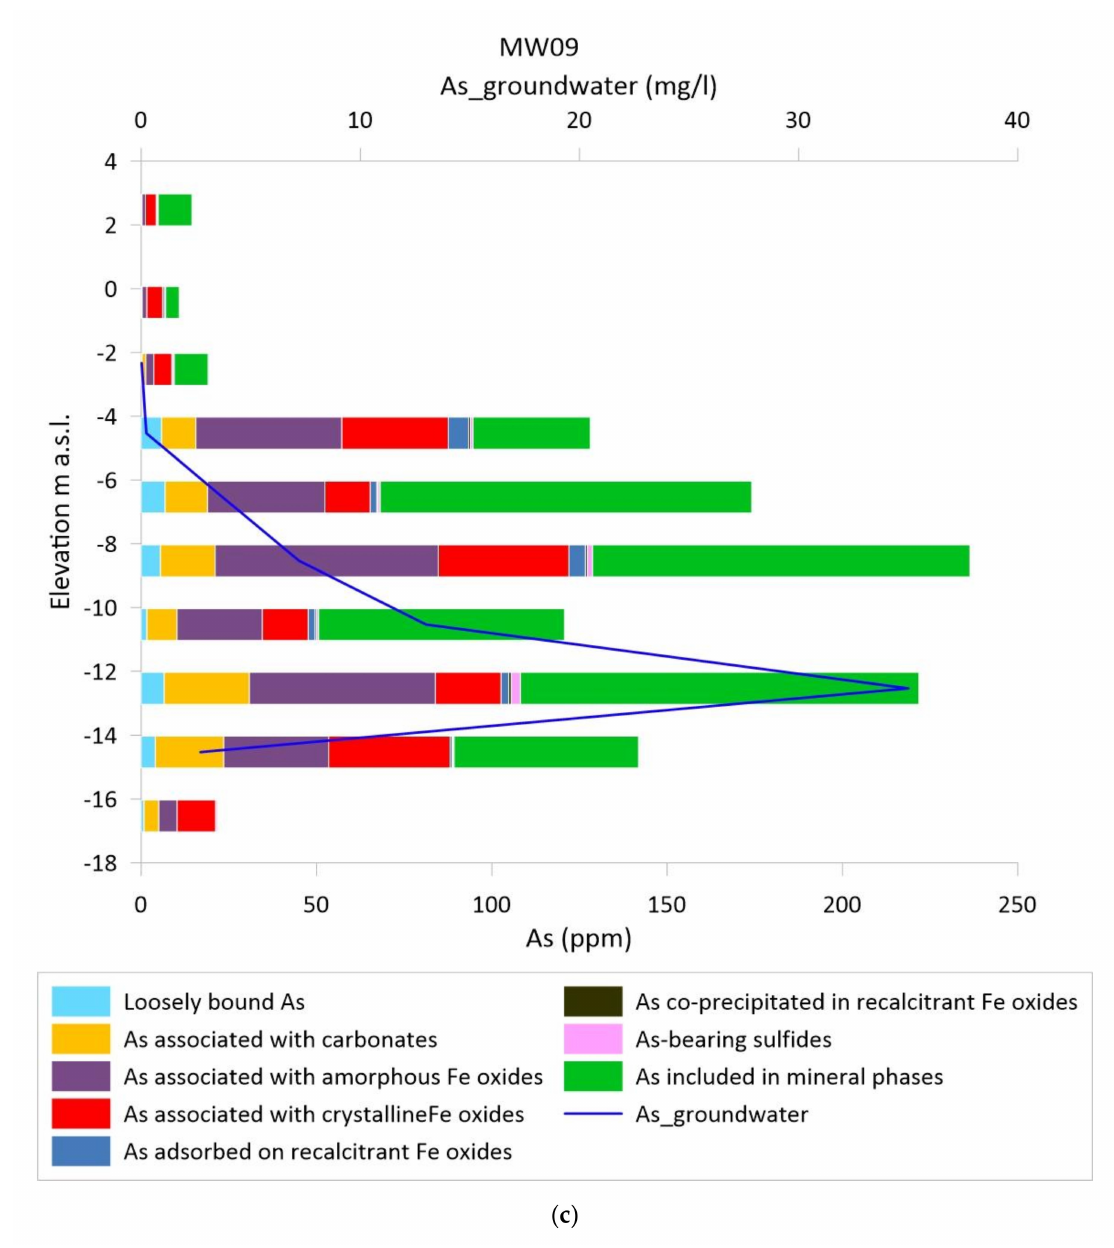
Figure 5. ( a ). Bar chart of sequential extraction results in MW07 compared with dissolved As vertical profile. ( b ) Bar chart of sequential extraction results in MW08 compared with dissolved As vertical profile. ( c ) Bar chart of sequential extraction results in MW09 compared with dissolved As vertical